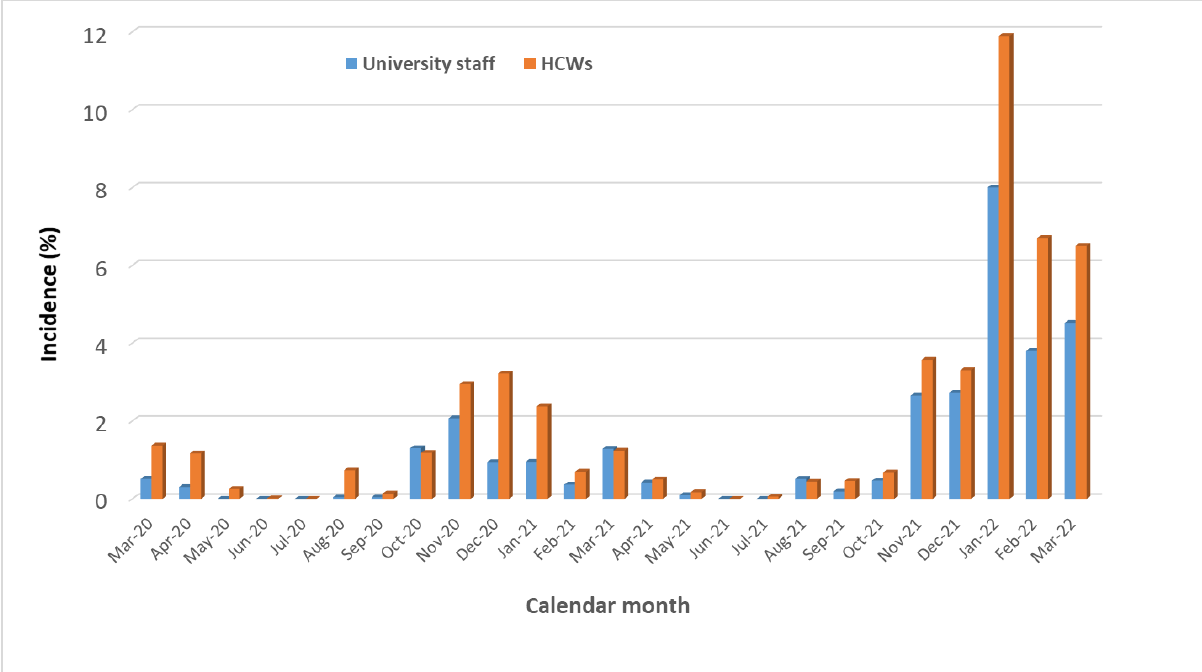
Figure 2. Distribution of primary SARS-CoV-2 infections by calendar month (1 March 2020 – 2 April 2022) among workers of the University of Trieste.